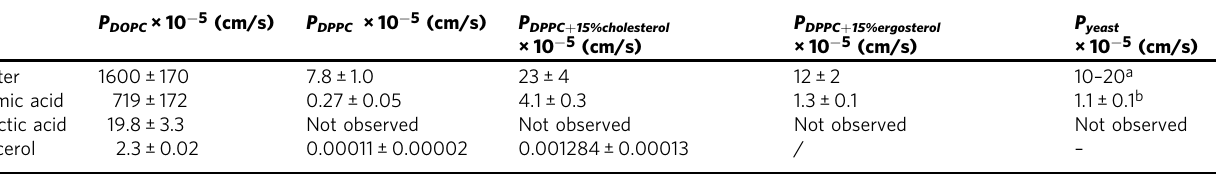
Table 1 Permeability coef fi cients in cm/s of water, formic acids, lactic acid and glycerol for lipid vesicles in different physical states and yeast